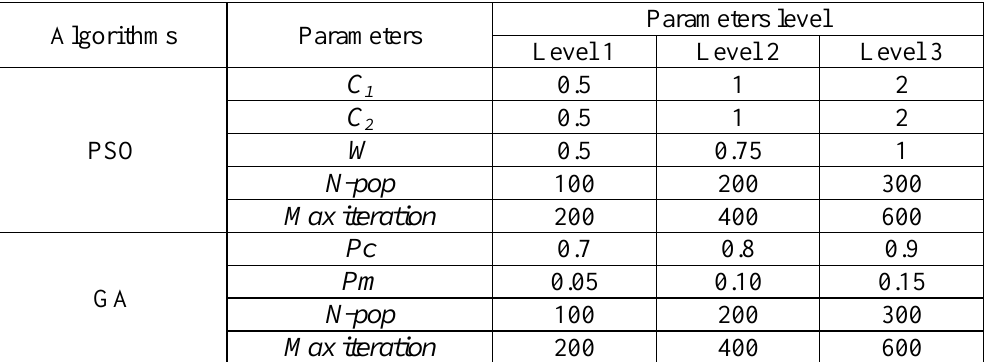
Table 1. The parameters levels of each algorithm